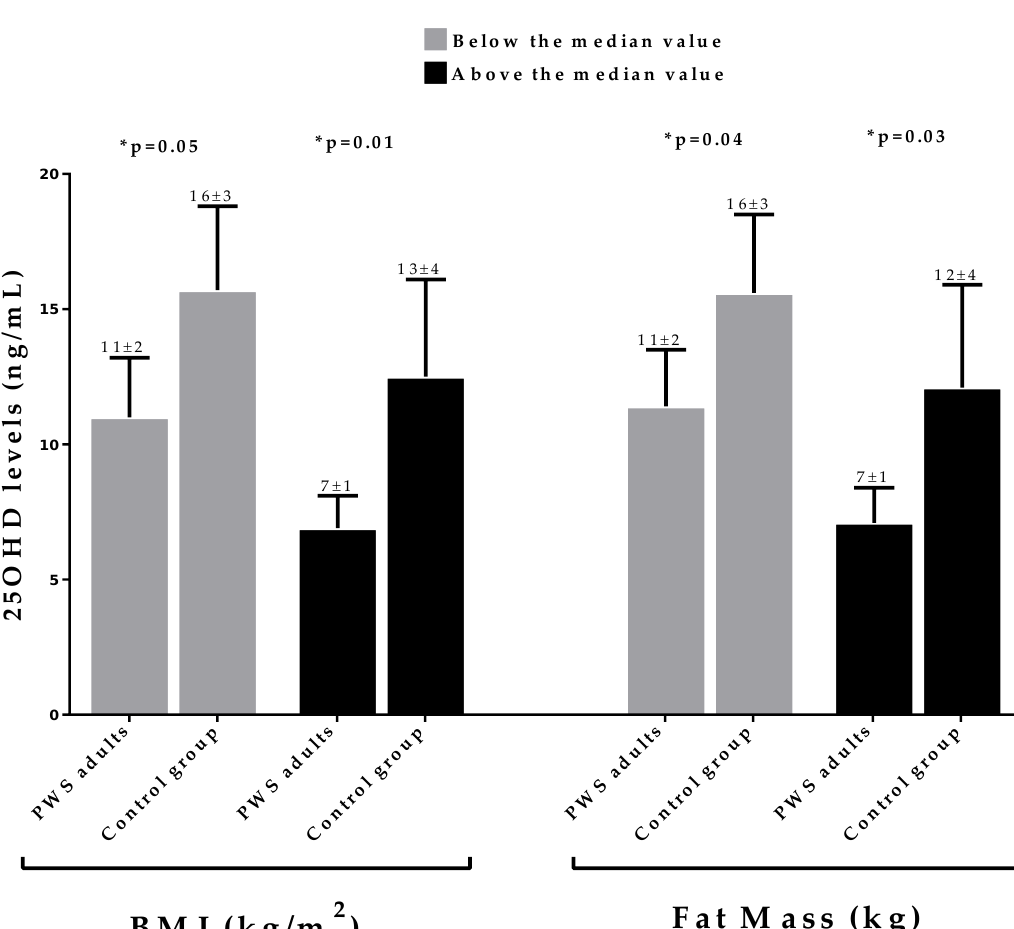
Figure 4. The differences in 25OHD levels between PWS adults and the control group for each BMI and fat mass category (above and below the median values). In each BMI and fat mass category the 25OHD levels were significantly lower in PWS adults than in the control group. * A p value < 0.05 means a significant difference. PWS, Prader–Willi syndrome; BMI, Body Mass index. Correlation Analysis